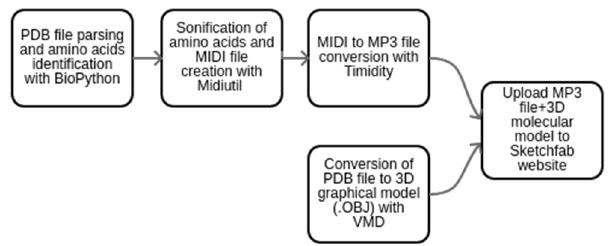
Figure 3. The sonification development process.